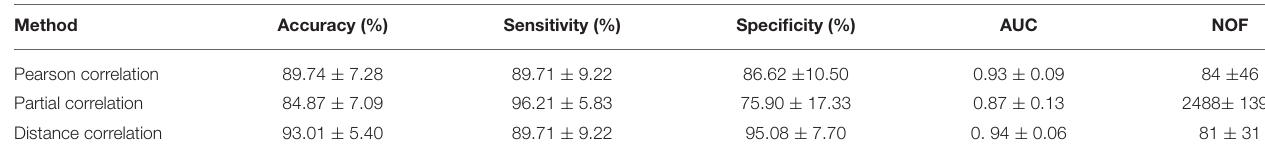
TABLE 3 | The classification results of the three correlation